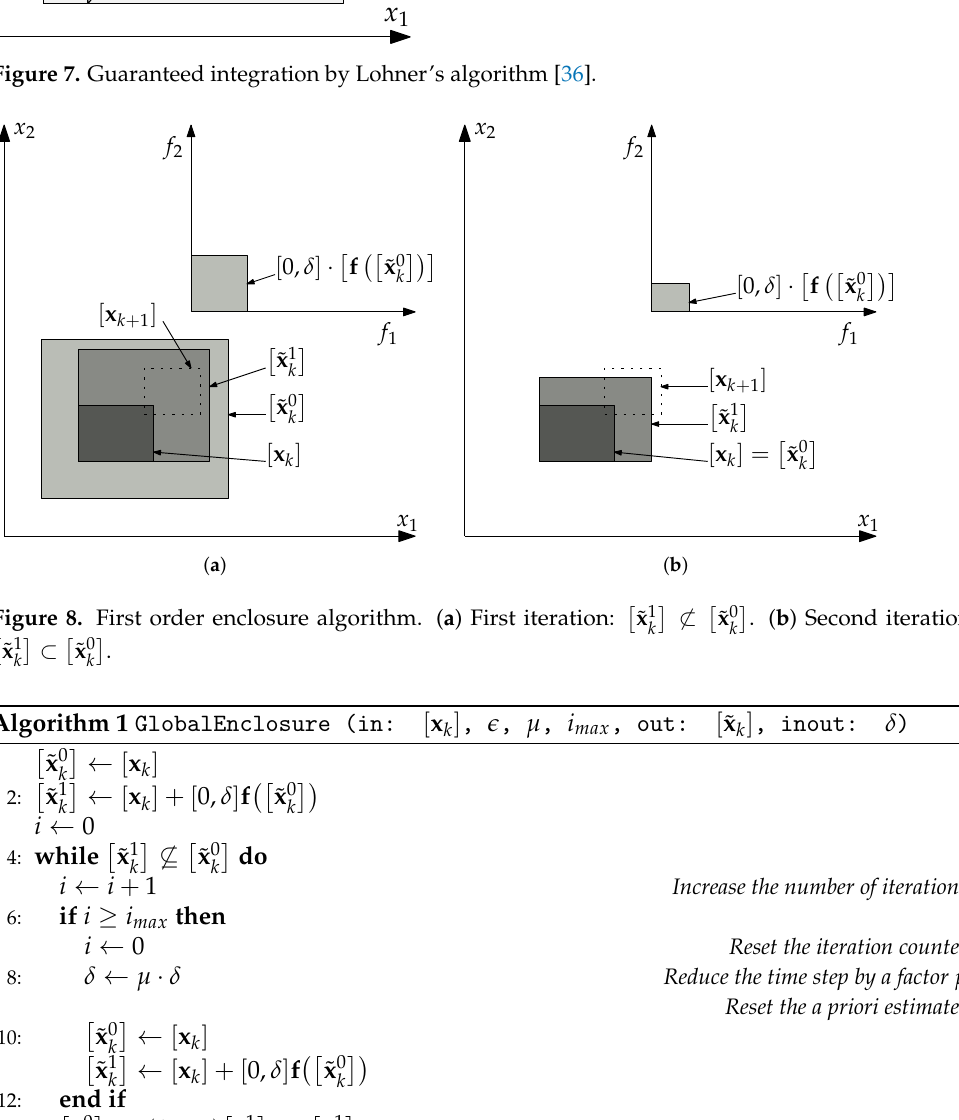
Algorithm 1 GlobalEnclosure